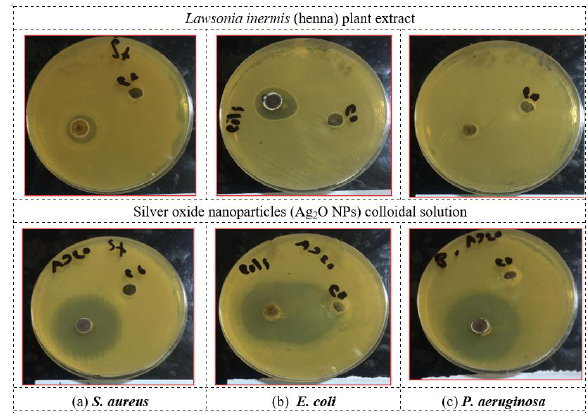
Figure 7: Antibacterial assay test using well diffusion method of Lawsonia inermis (henna) plant extract and Ag 2 O NPs against (a) S. aureus , (b) E. coli , (c) P. aeruginosa .